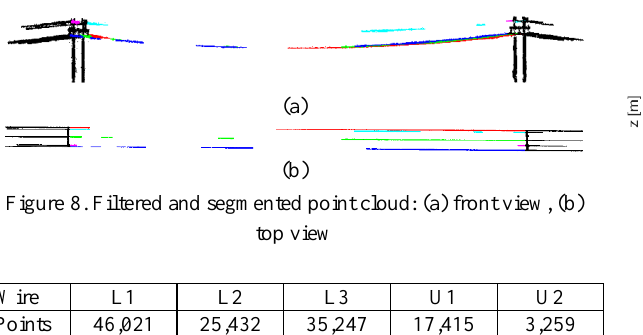
Table 3. Number of points segmented for each wire